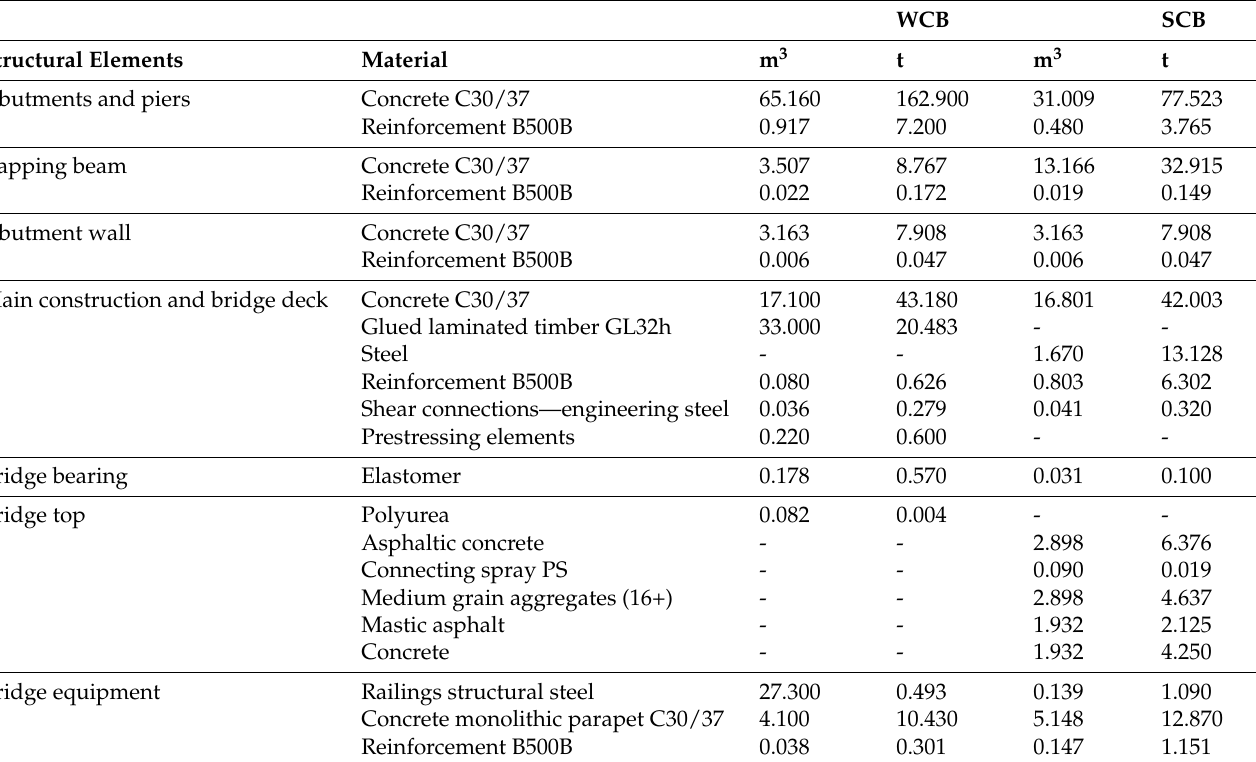
Table 1. Structural units and materials composition of WCB and SCB